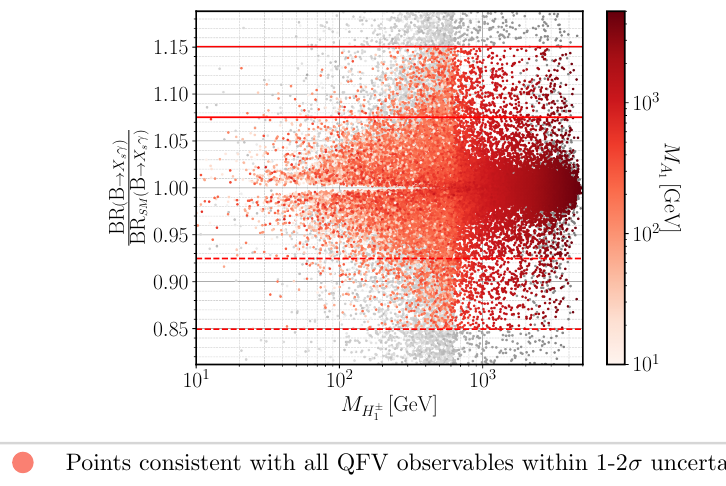
Figure 4 . The ratio of 3HDM-to-SM branching fractions for B → X s γ decay in the considered BGL-like 3HDM as a function of the H ± mass. Red-shaded points are those for which all QFV 1 constraints are satisfied at most at 2 σ (many even at 1 σ ) level, grey points are those for which at least one QFV observable is in disagreement with the current measurements by more than 2 σ . The horizontal lines account for the 1 and 2 σ uncertainties as in the first line of table 1. The “temperature” gradient of colour shows the lightest pseudoscalar